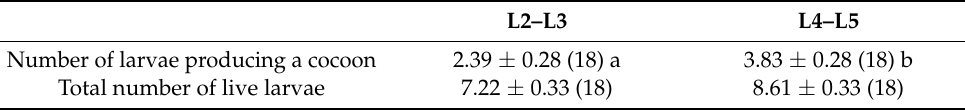
Different letters indicate differences in the number of cocoons produced by the larvae of the different age